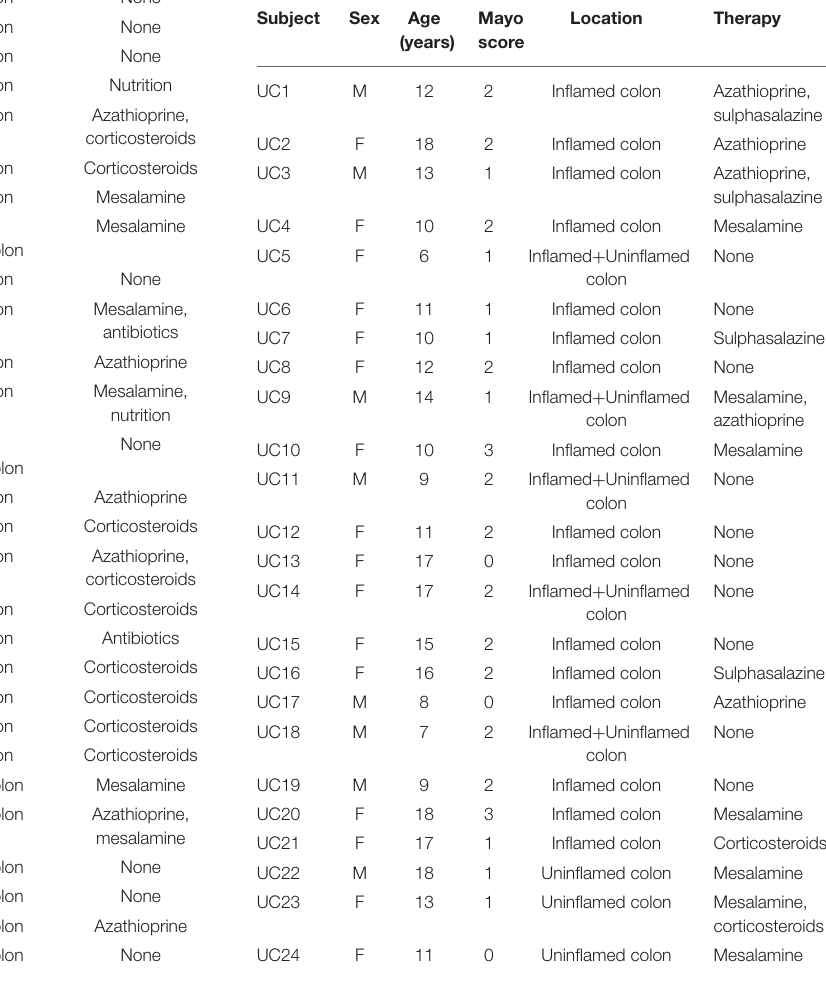
TABLE 2 | Characteristics of the UC study